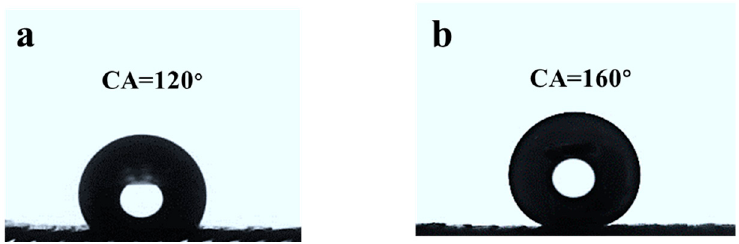
Figure 4. Static water contact angle on the elastic membranes ( a ) before and ( b ) after laser ablation.